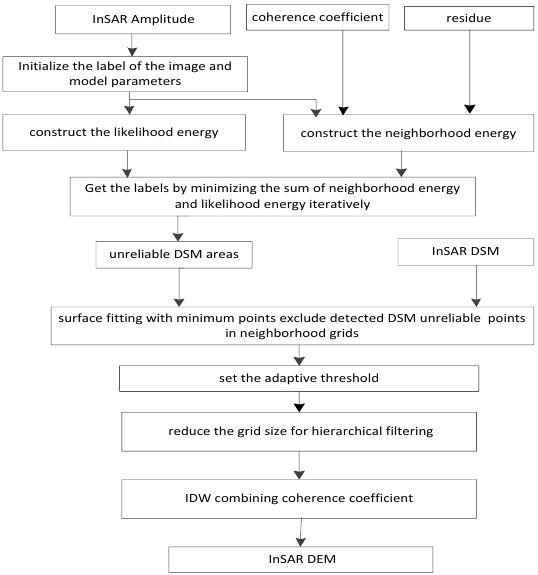
Figure 6. Flowchart of proposed digital elevation model (DEM) reconstruction method.